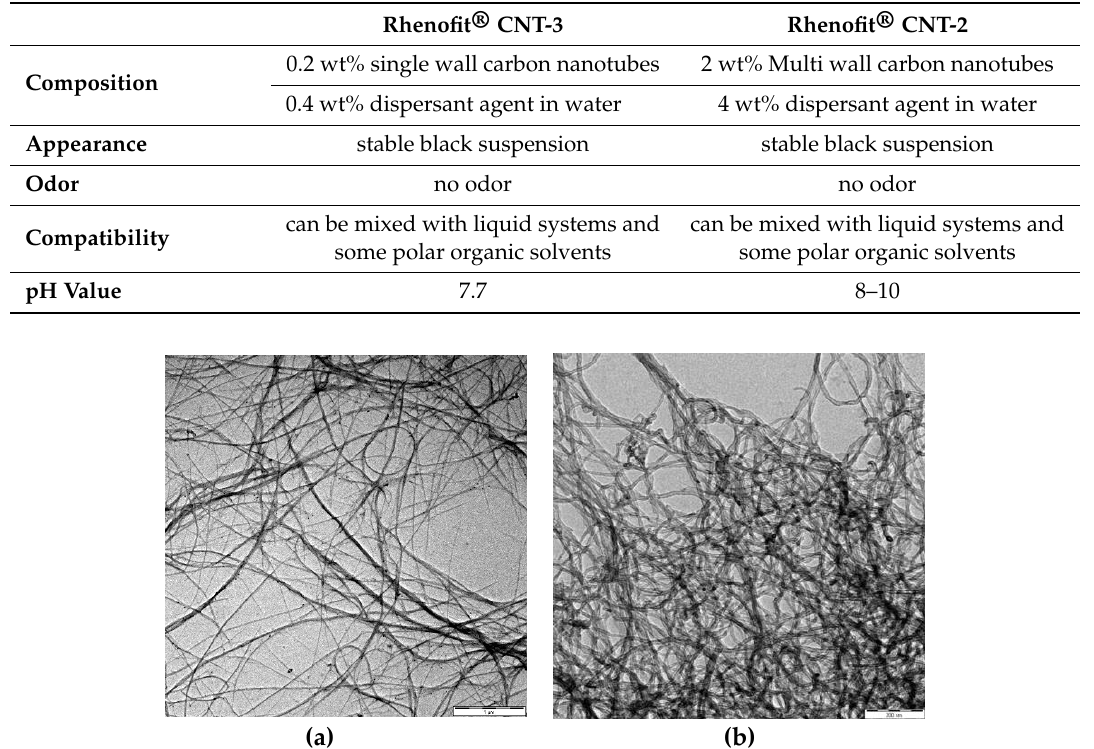
Table 2. Brief technical data sheet of Rhenofit ® CNT-3 / Rhenofit ® CNT-2.